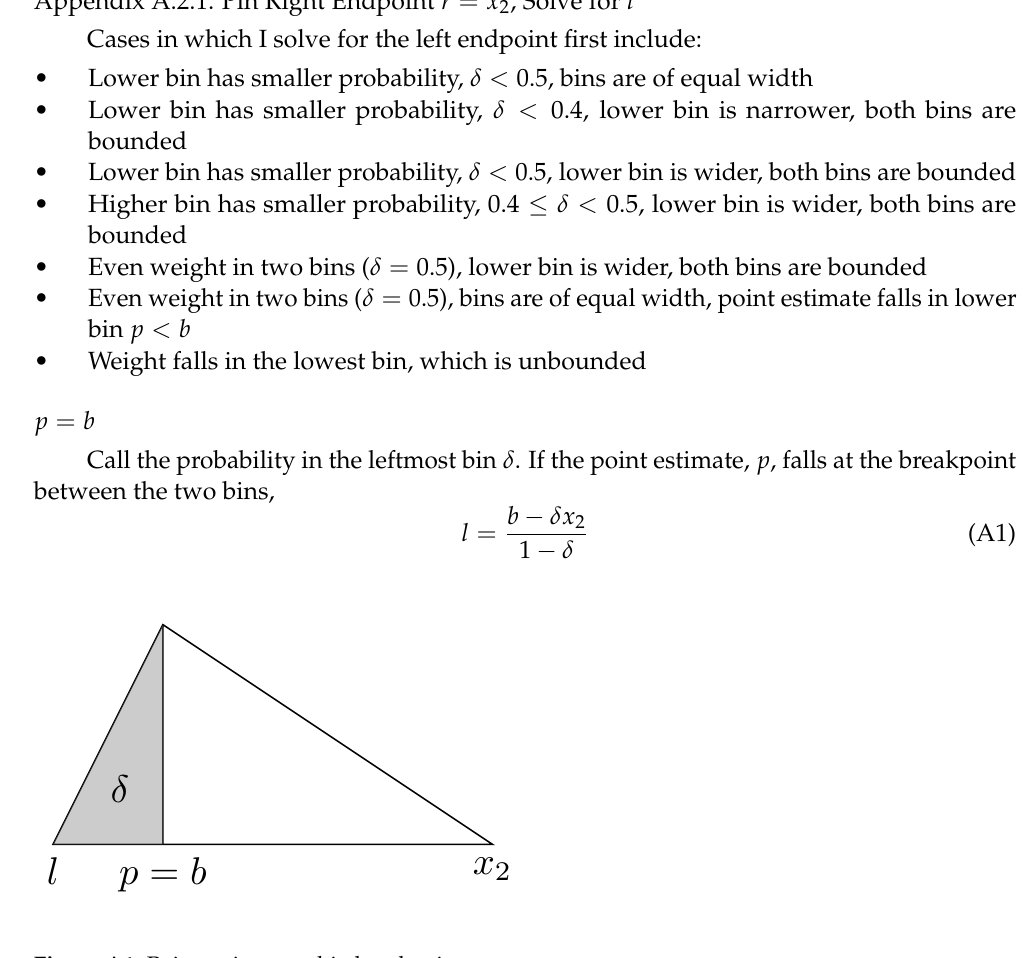
Figure A1. Point estimate at bin breakpoint.